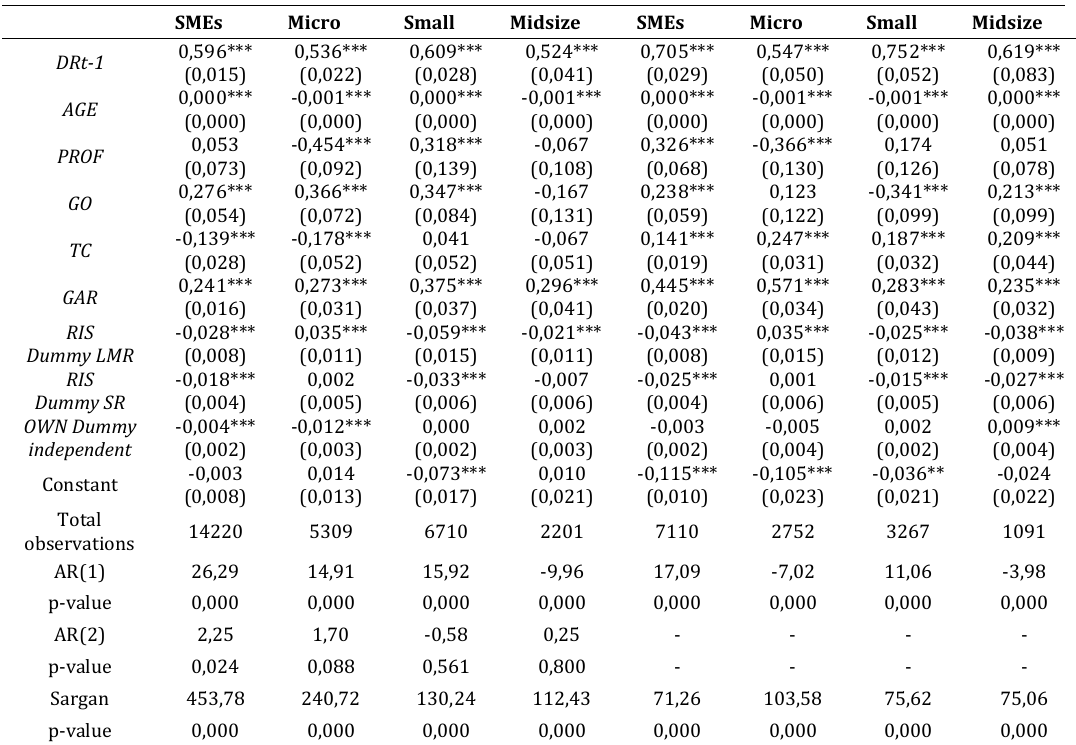
Table 5. Outcomes from dynamic estimates (GMM-SYS) of the debt